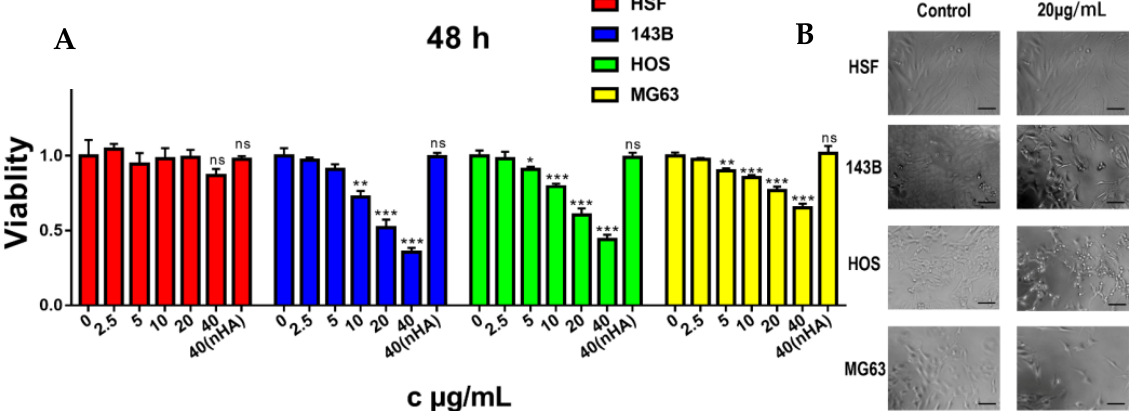
Figure 5. ( A ) Cytotoxicity evaluation of MTX-PEG-nHA at different concentrations on three kinds of osteosarcoma cells. ( B ) Morphological change in HSF, 143B, HOS, and MG63 (left) and those cells treated with MTX-PEG-nHA (right). * p < 0.05, ** p < 0.01, *** p < 0.001, represent significant differences, while ns means no statistical difference. The scale bar in ( B ) is 100 µ